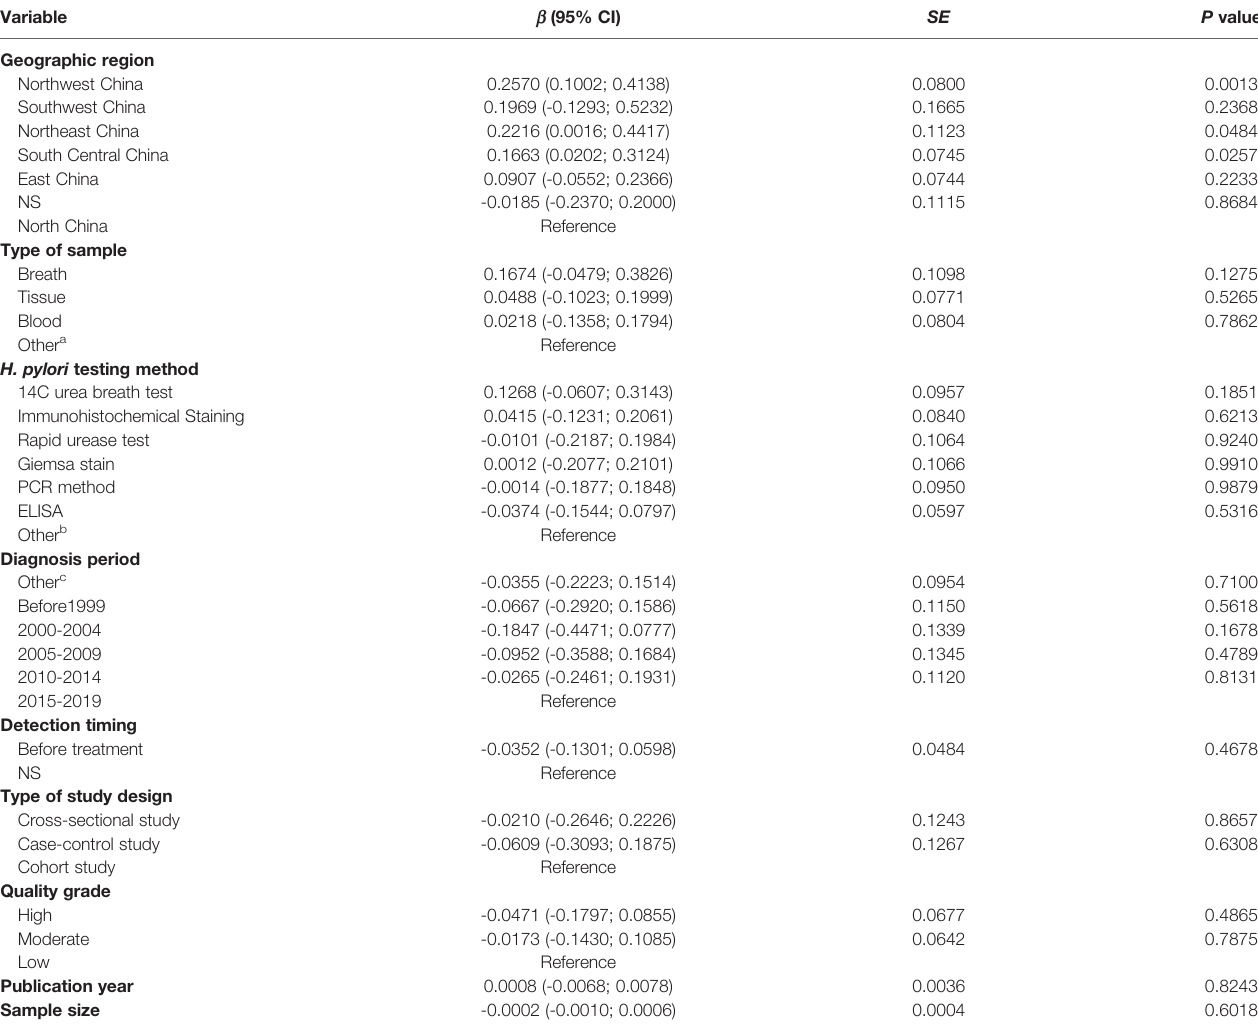
TABLE 2 | Assessing the effect of study variables on the pooled prevalence of Helicobacter pylori in non-cardia gastric cancer in China using univariable meta- regression analysis. Variable b (95% CI) P value Geographic region Northwest